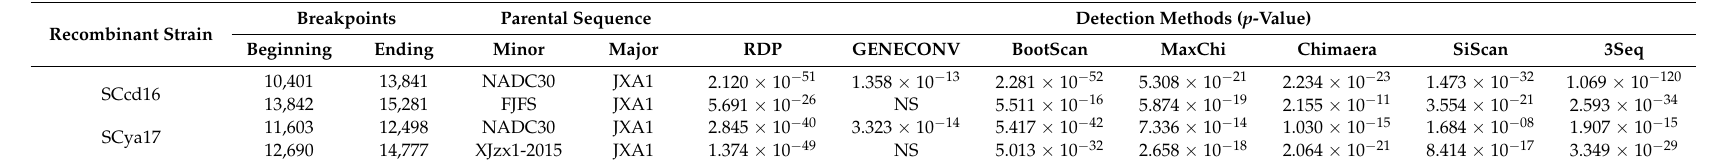
Table 2. Information on recombination events detected in SCcd16 and